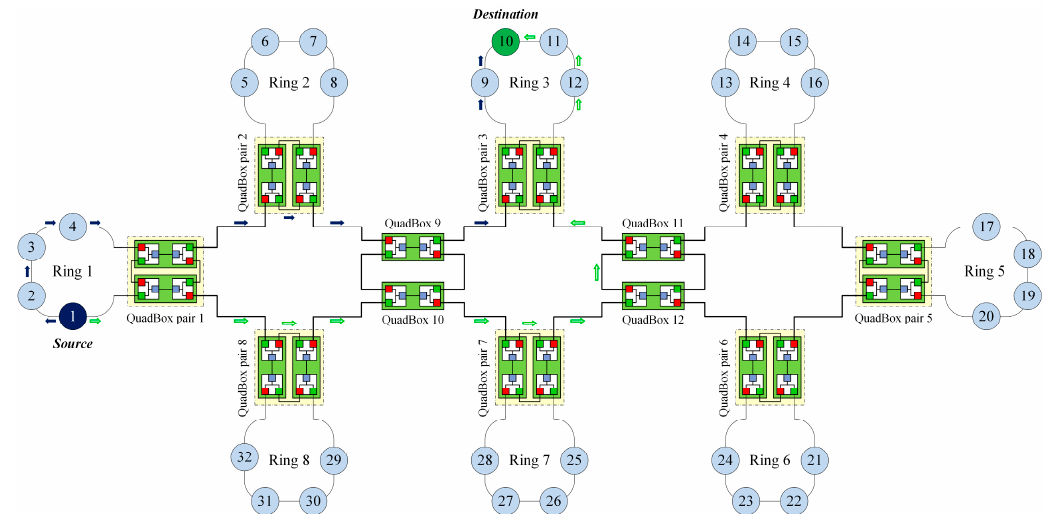
Figure 8. Network traffic under the DSP-based approach.